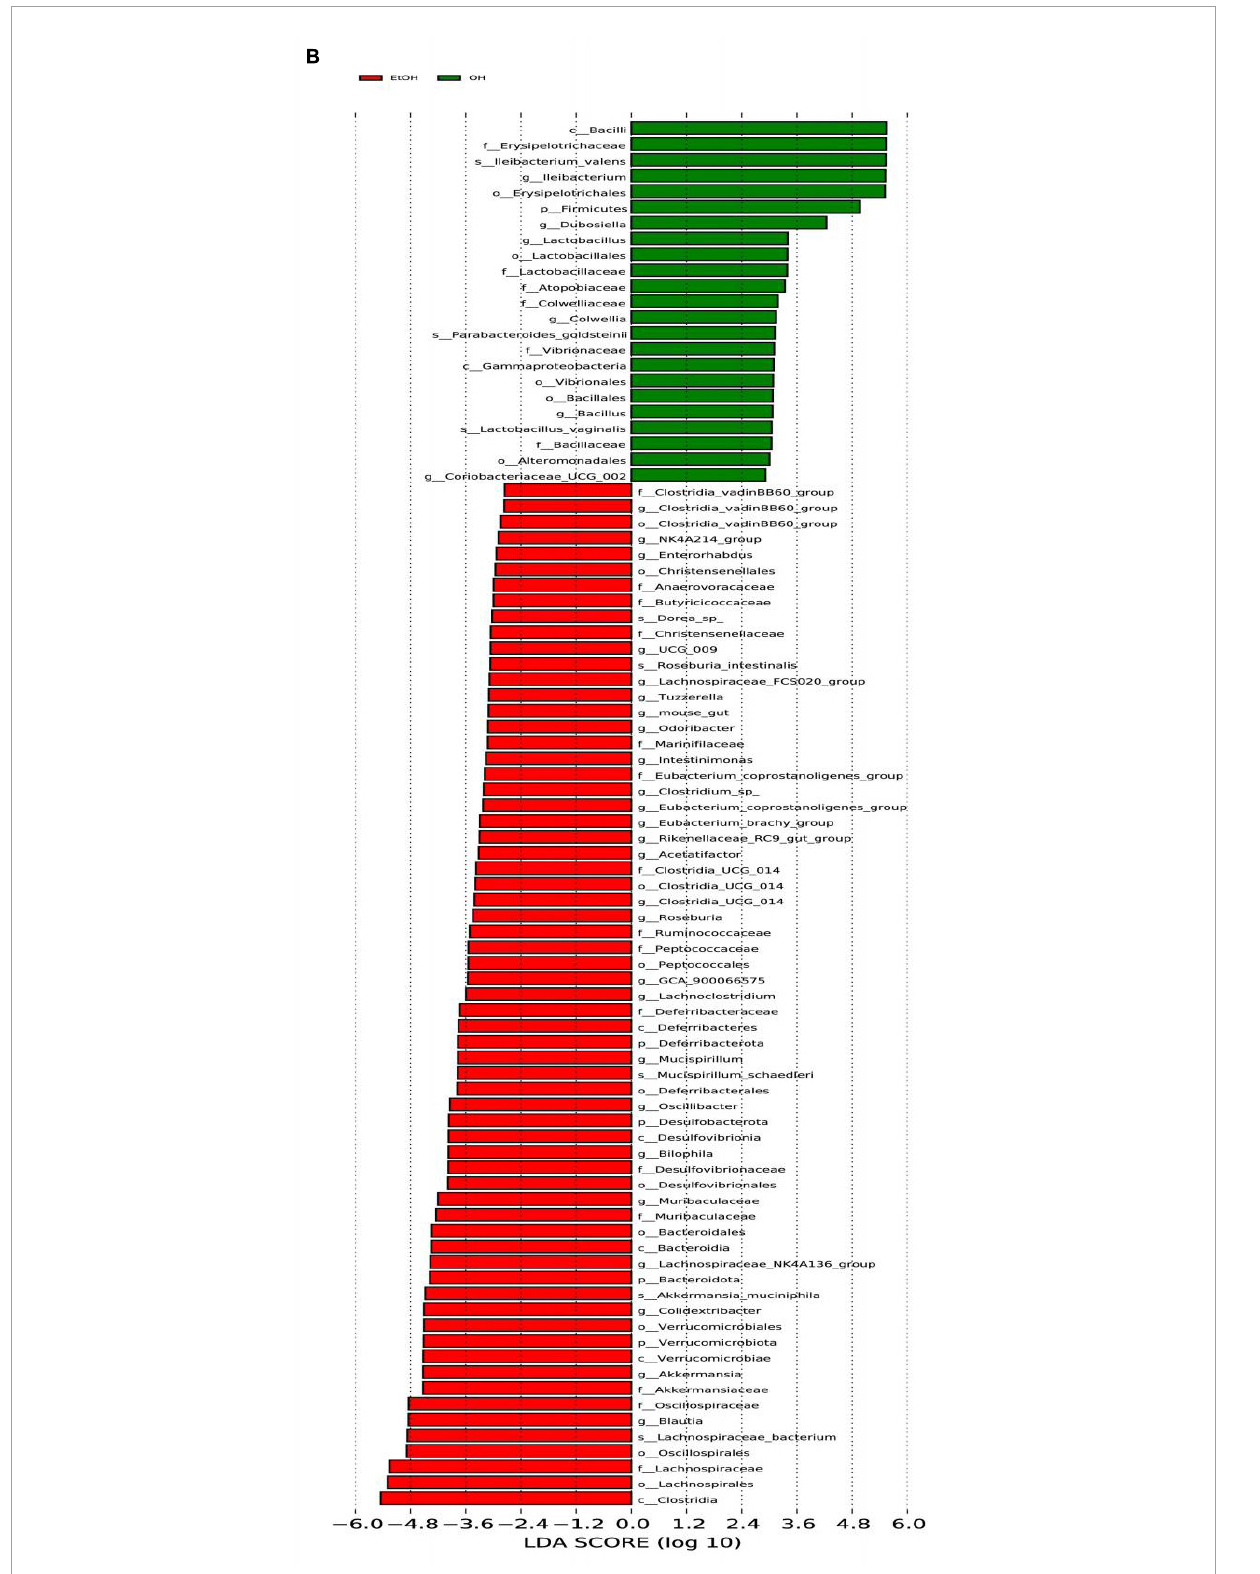
FIGURE8 LEfSe analysis of gut microbiota between the EtOH and OH groups. (A) Cladogram and (B) LDA score. EtOH, ethanol administration group; OH, high-dose OEB group.